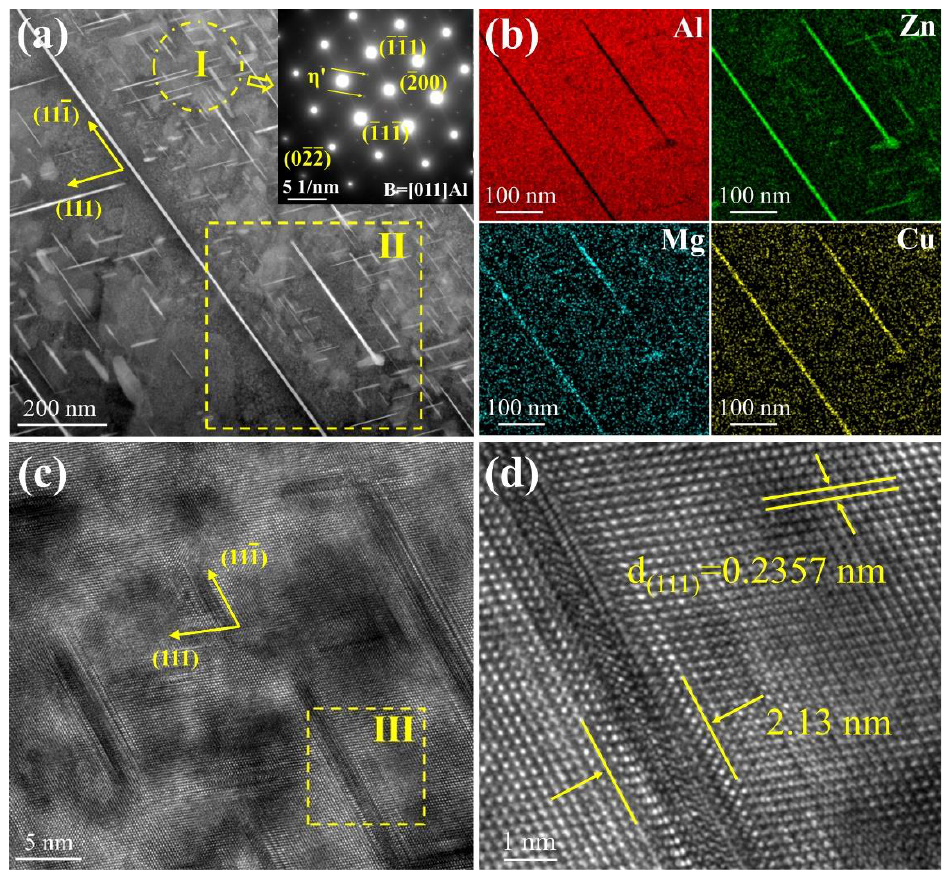
Figure 4. Typical TEM image of the 13Zn alloy ( a ) precipitate ’ s topography and SADPs along the [011] Al axis; ( b ) Element mapping of precipitates; ( c ) HRTEM image of η ’ phase; ( d ) Zone III in image ( c ).